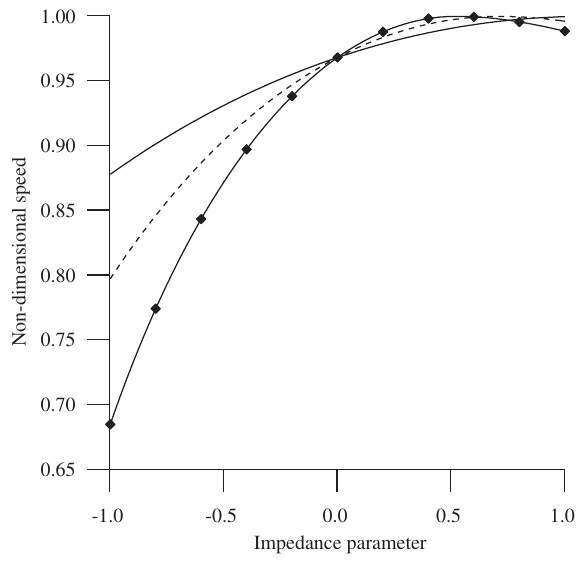
Figure 3: Variation of non-dimensional speed of a Rayleigh wave against an impedance parameter ∗ (solid curve with centre symbols), ∗ = (dotted curve).